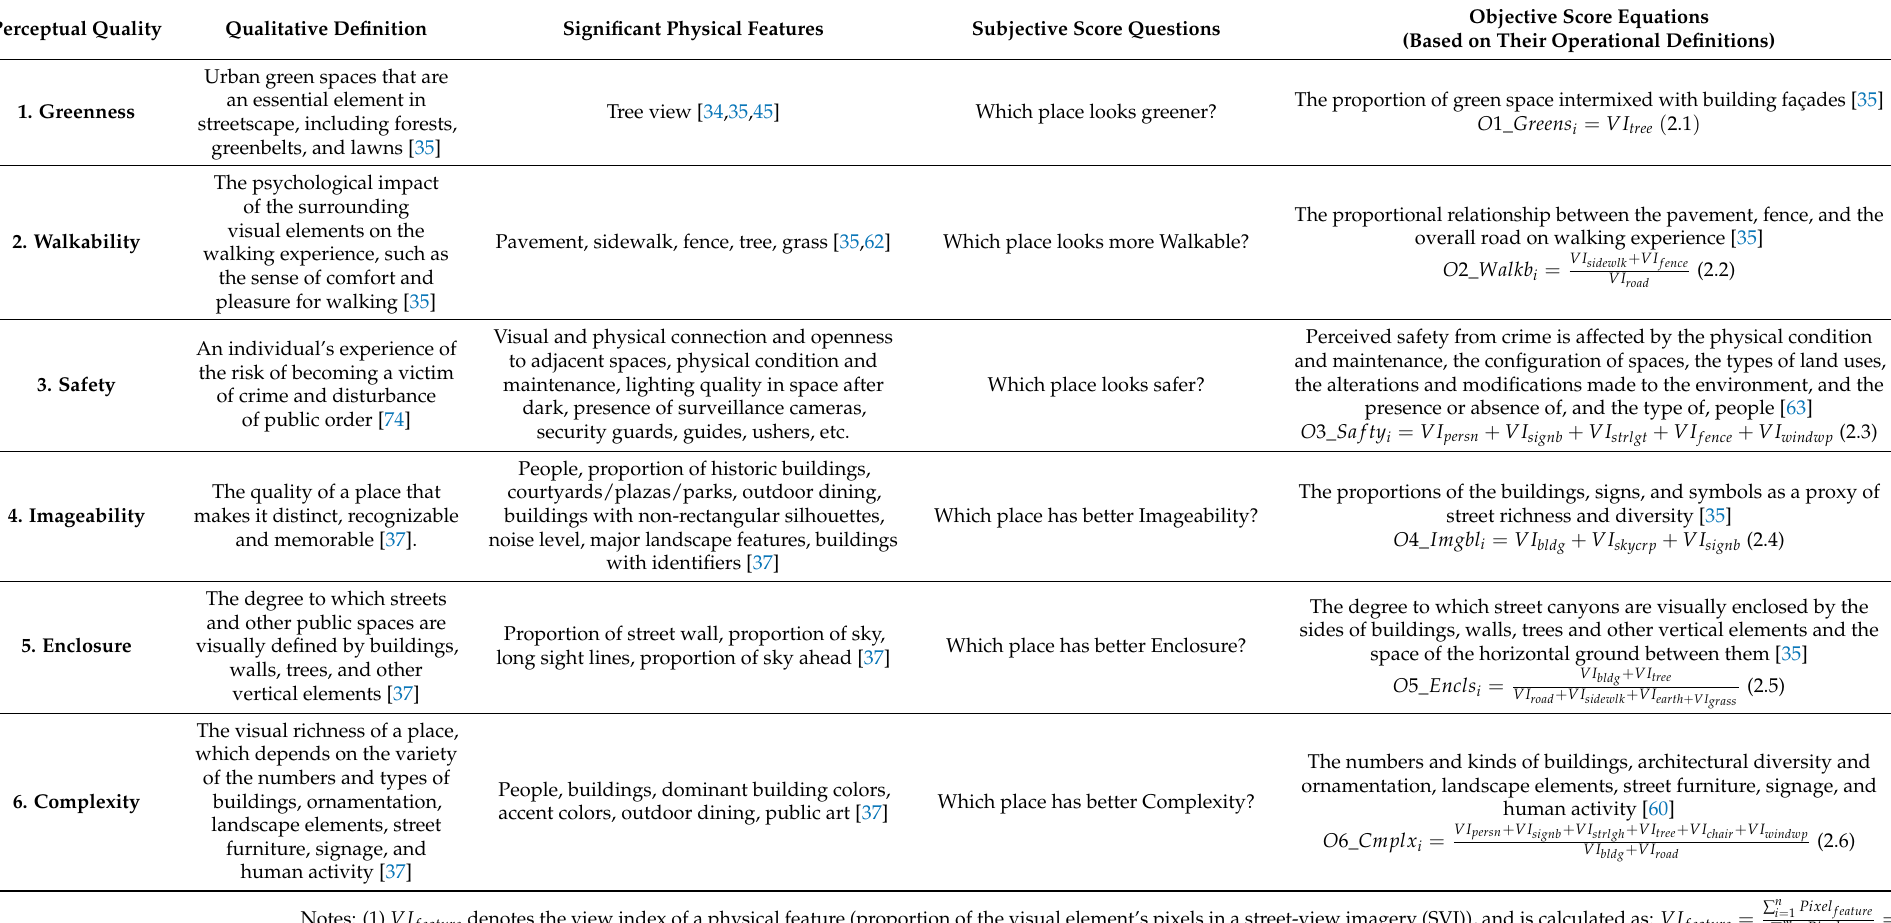
Table 1. Definitions and equations for six perceptual